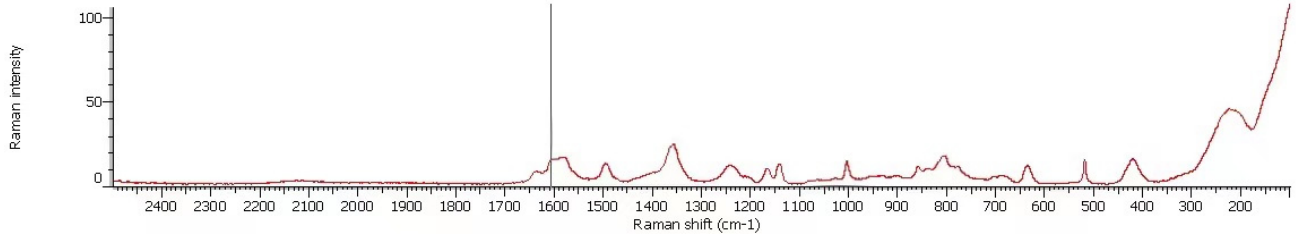
Figure 5. Raman spectroscopy on the position (micrometres) = 8924 μ m, point #211.